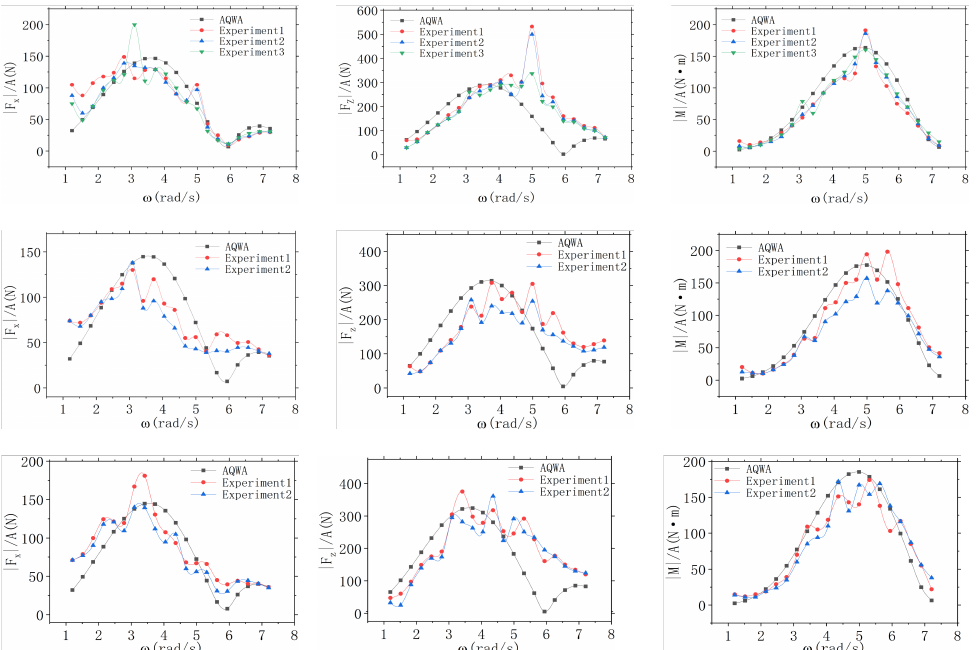
Figure 25. Verification of numerical investigation results of wave force based on the 21UUV model. From the top row to the bottom row: curves of the longitudinal force, vertical force and pitching moment versus the wave circular frequency when u = 0 m/s, 0.489 m/s, 0.733 m/s.